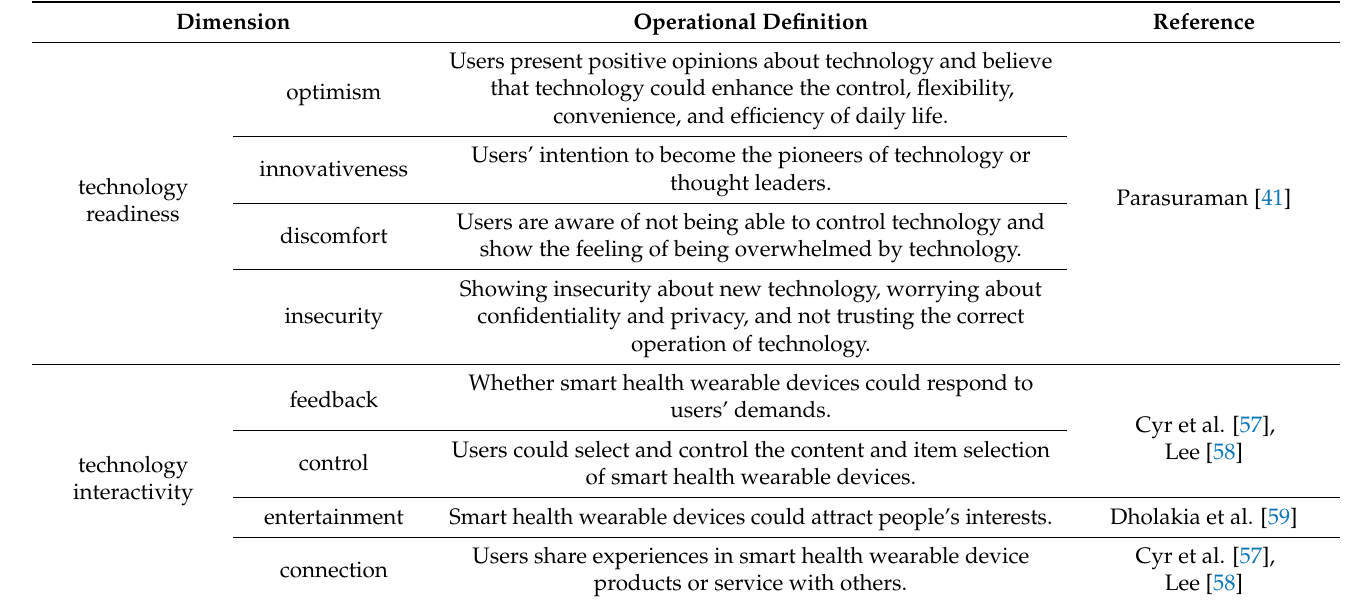
Table 1. Operational definitions of variables and sources of